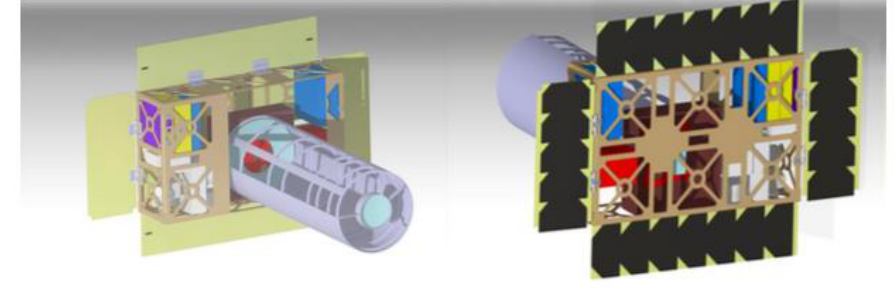
Figure 4. Spacecraft CAD model.